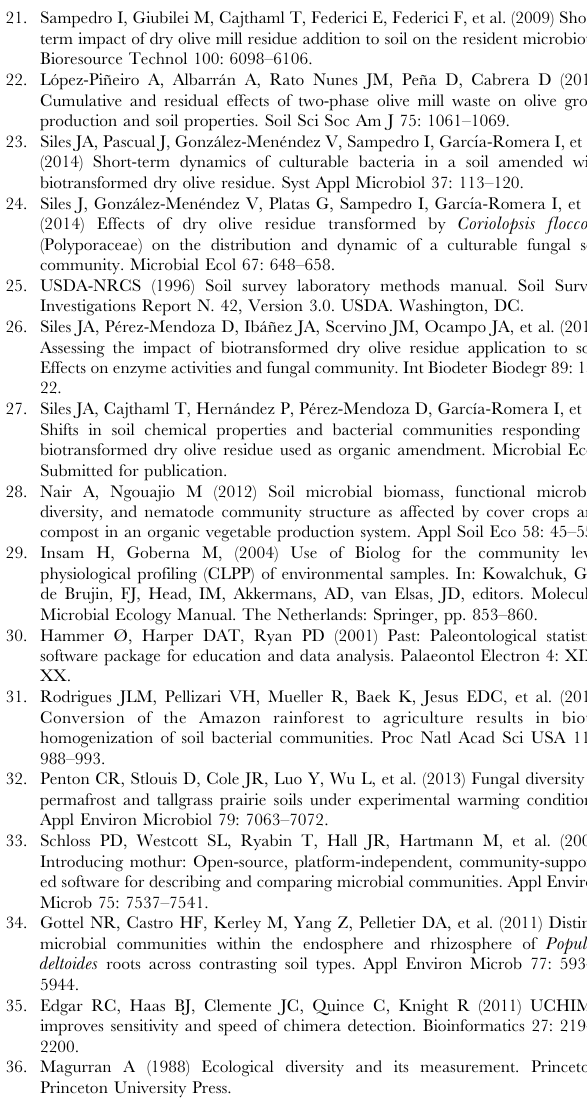
Table S1 Soil chemical properties. The chemical properties of the soil used in the study (mean 6 standard deviation). Table S2 Correlation of carbon sources with principal coordi- nates. Correlation of carbon sources with the first (PC1) and second principal coordinates (PC2) after principal coordinate analysis (PCoA) of community level physiological profiles (CLPP) from unamended soil and soil amended with untransformed DOR or C. floccosa –transformed DOR at 0, 30 and 60 days. Table S3 Identification and abundance of the major bacterial OTUs. Basic information of the bacterial 14 most abundant OTUs and their relative abundance (percent) in unamended soil (C) and soil amended with untransformed DOR (DOR) or C.